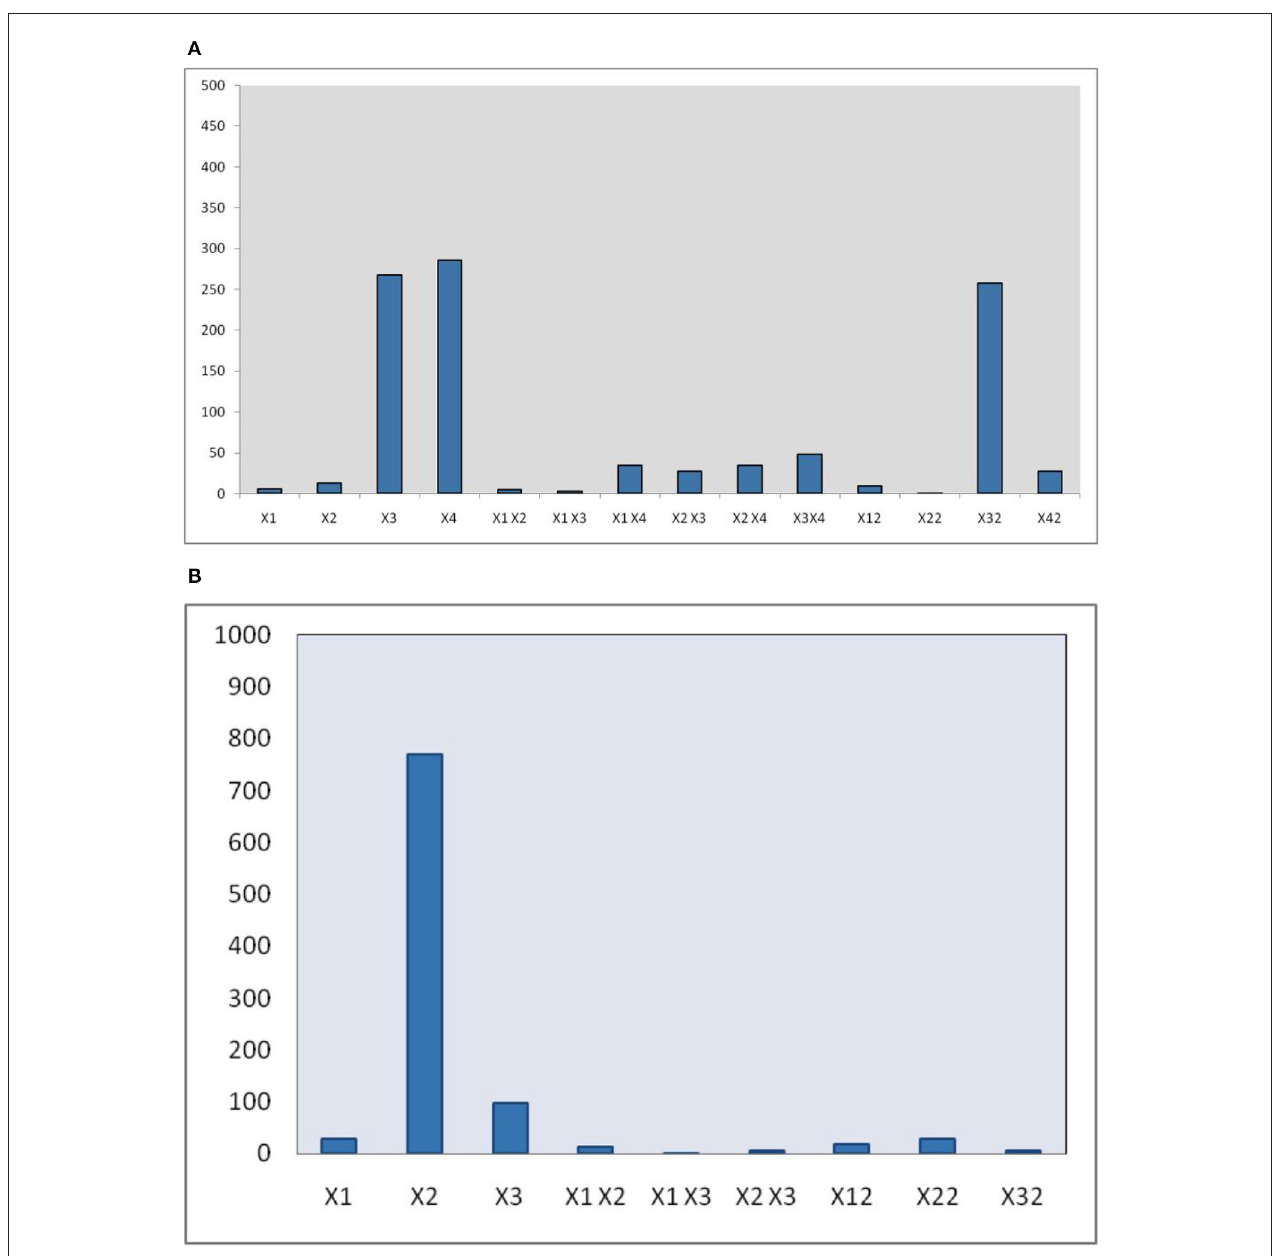
FIGURE 2 | Pareto chart indicating magnitude of different variables/terms on EY (A) MAE (B)